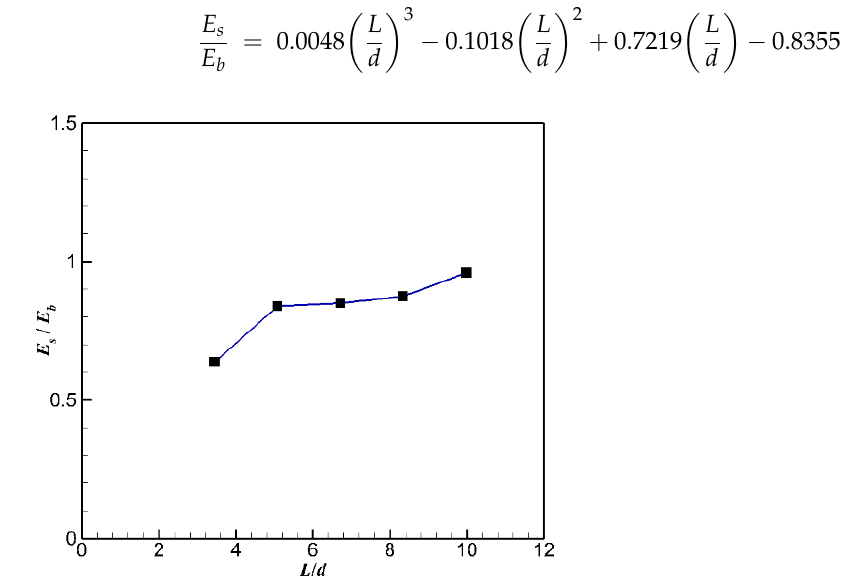
Figure 10. Effect of relative particle size in three-point bending test.